Question: Write a single sentence explaining what this figure depicts.
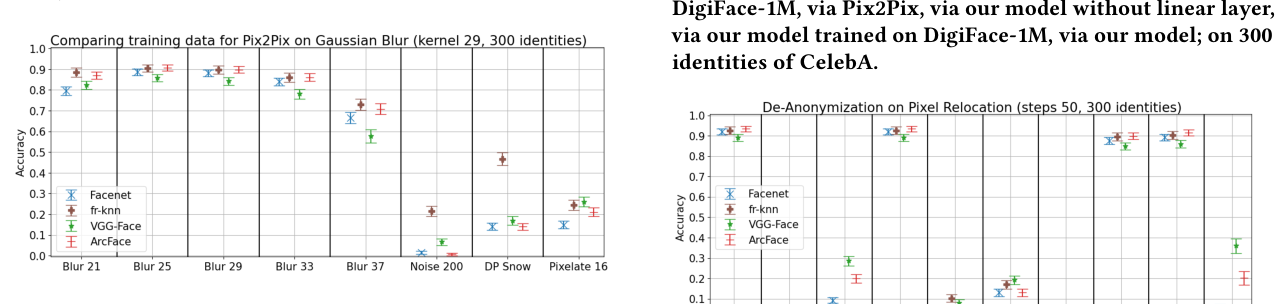
Answer: Recognition accuracy for Gaussian Blur (kernel 29), given for de-anon. via Pix2Pix trained on Gaussian Blur (Kernel 21, 25, 29, 33, 37), Gaussian Noise (sigma 200), DP Snow, or Pixelation (16)